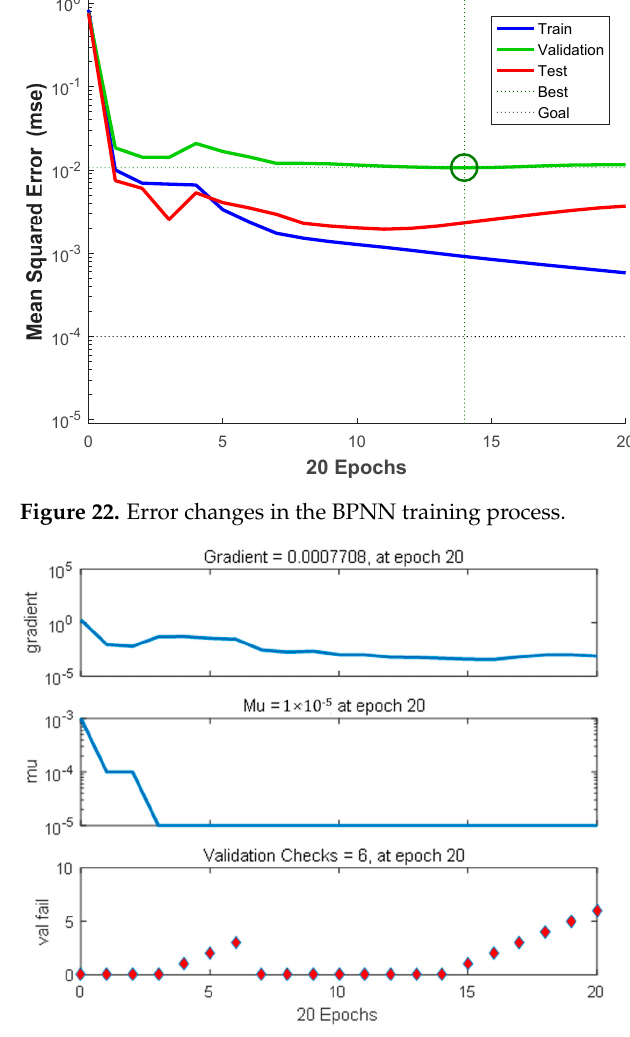
Figure 21. RMSE value of BPNN model based on Tan-Sigmoid (double hidden layers). Figure 22 shows the error reduction process during the BPNN training, which pro- vides an optimal representation of the model training process. The blue line in the figure represents the network training error, the green line represents the network verification error, and the red line represents the test error. The training stops when the verification error reaches the set target or the verification error is no longer decreasing. Figure 23 shows the training status of BPNN.